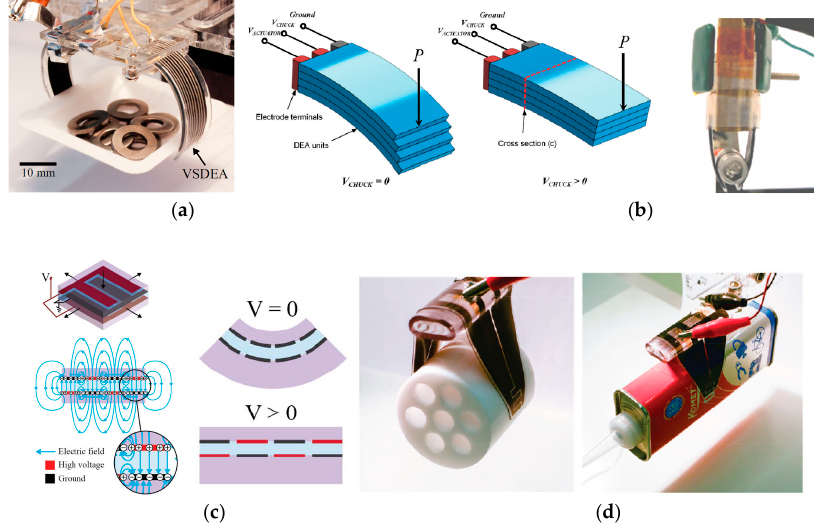
Figure 8. DE gripper with other enhancing strategy: ( a ) DE gripper with sti ff ness modulation of LMPA [91]; ( b ) DE gripper with sti ff ness modulation of electrostatic chucking [93]; ( c ) multipurposed electro-adhesion pattern for DE actuation [94]; ( d ) Grasping objects by using DE gripper with electro-adhesion